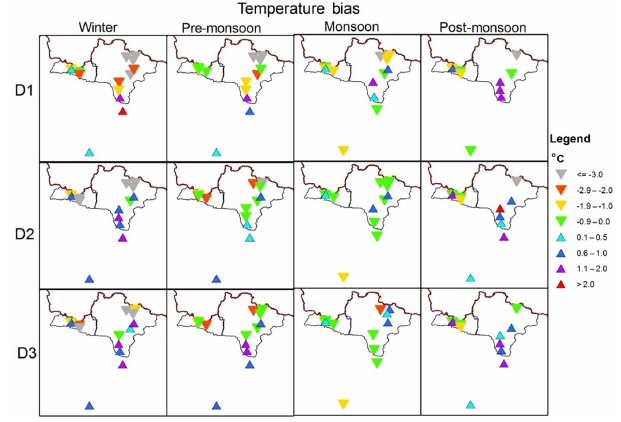
Figure 13. Station-wise seasonal bias in temperature ( ◦ C) in all four seasons for three WRF resolutions zoomed over station loca- tions